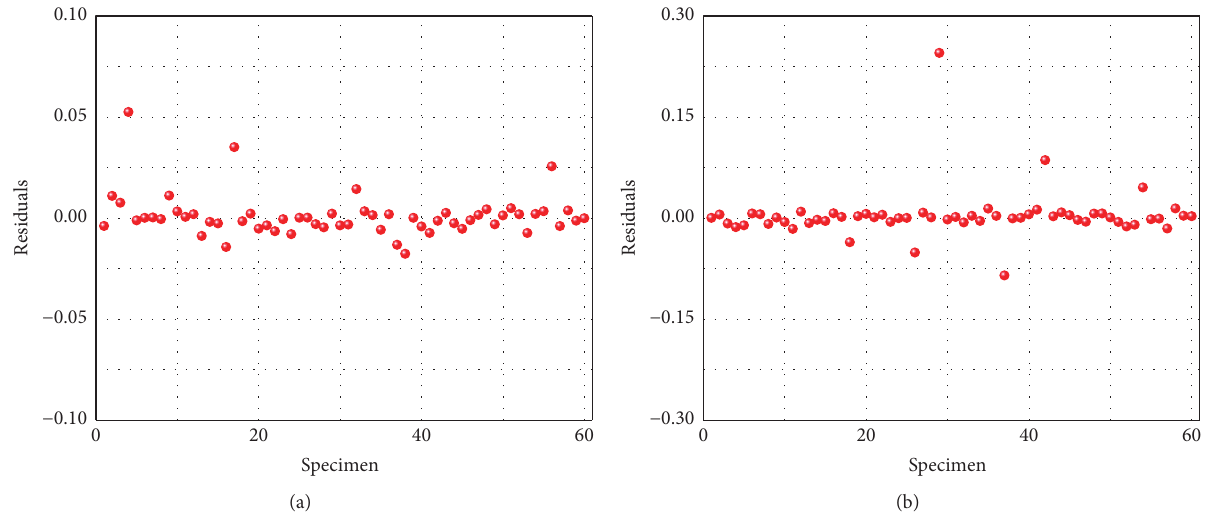
Figure 3: Mean of residuals obtained by fitting Ghonem and Dore Set I (a) and Ghonem and Dore Set III (b).